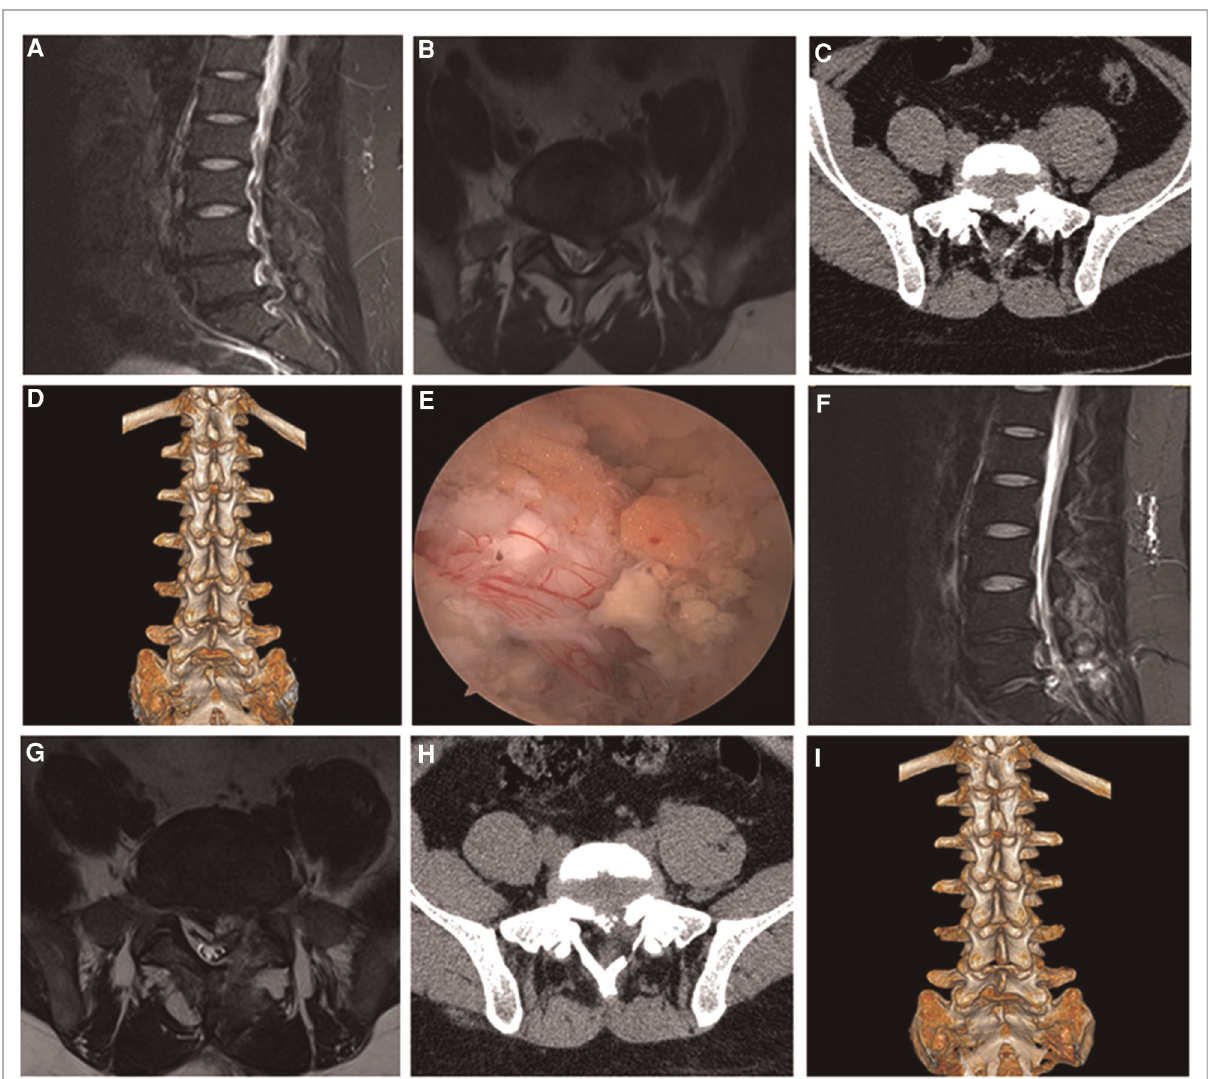
FIGURE 2 Male, 28 years old, L5/S1 lumbar disc herniation with posterior apophyseal ring separation. ( A ) Preoperative sagittal MR image showed L5/S1 lumbar disc herniation; ( B ) Preoperative axial MR image showed herniated lumbar disc compressed nerve root and dural sac; ( C ) Preoperative axial CT image showed separated bony fragment of vertebral body; ( D ) Preoperative 3D-CT image; ( E ) Intraoperative image after complete neural decompression; ( F ) Postoperative sagittal MR image revealed the complete decompression of the spinal canal; ( G ) Postoperative axial MR image showed the complete removal of herniated disc and bony fragment; ( H ) Postoperative axial CT image showed the removal of the bony fragment; ( I ) Postoperative 3D-CT image showed the lamina window and preservation of the facet